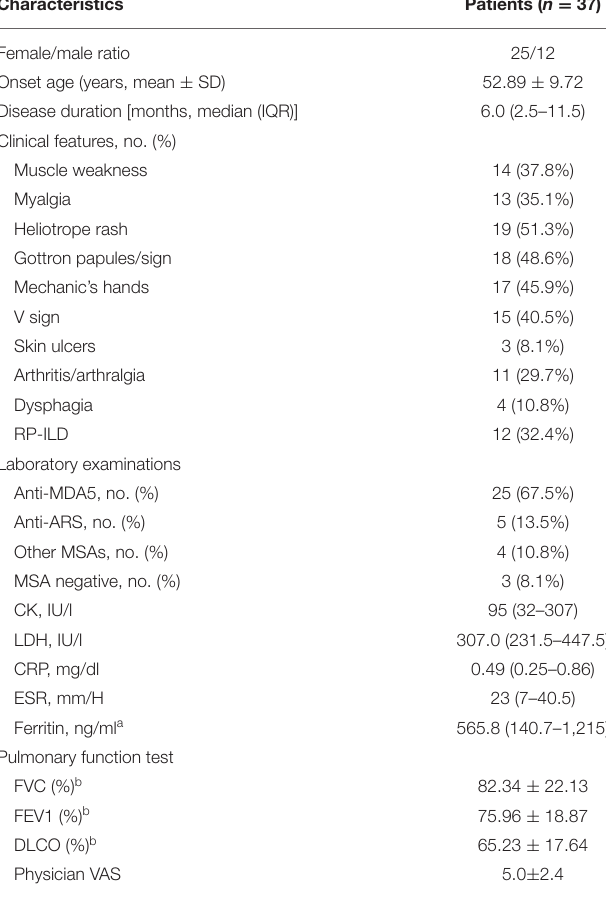
TABLE 1 | Characteristics of